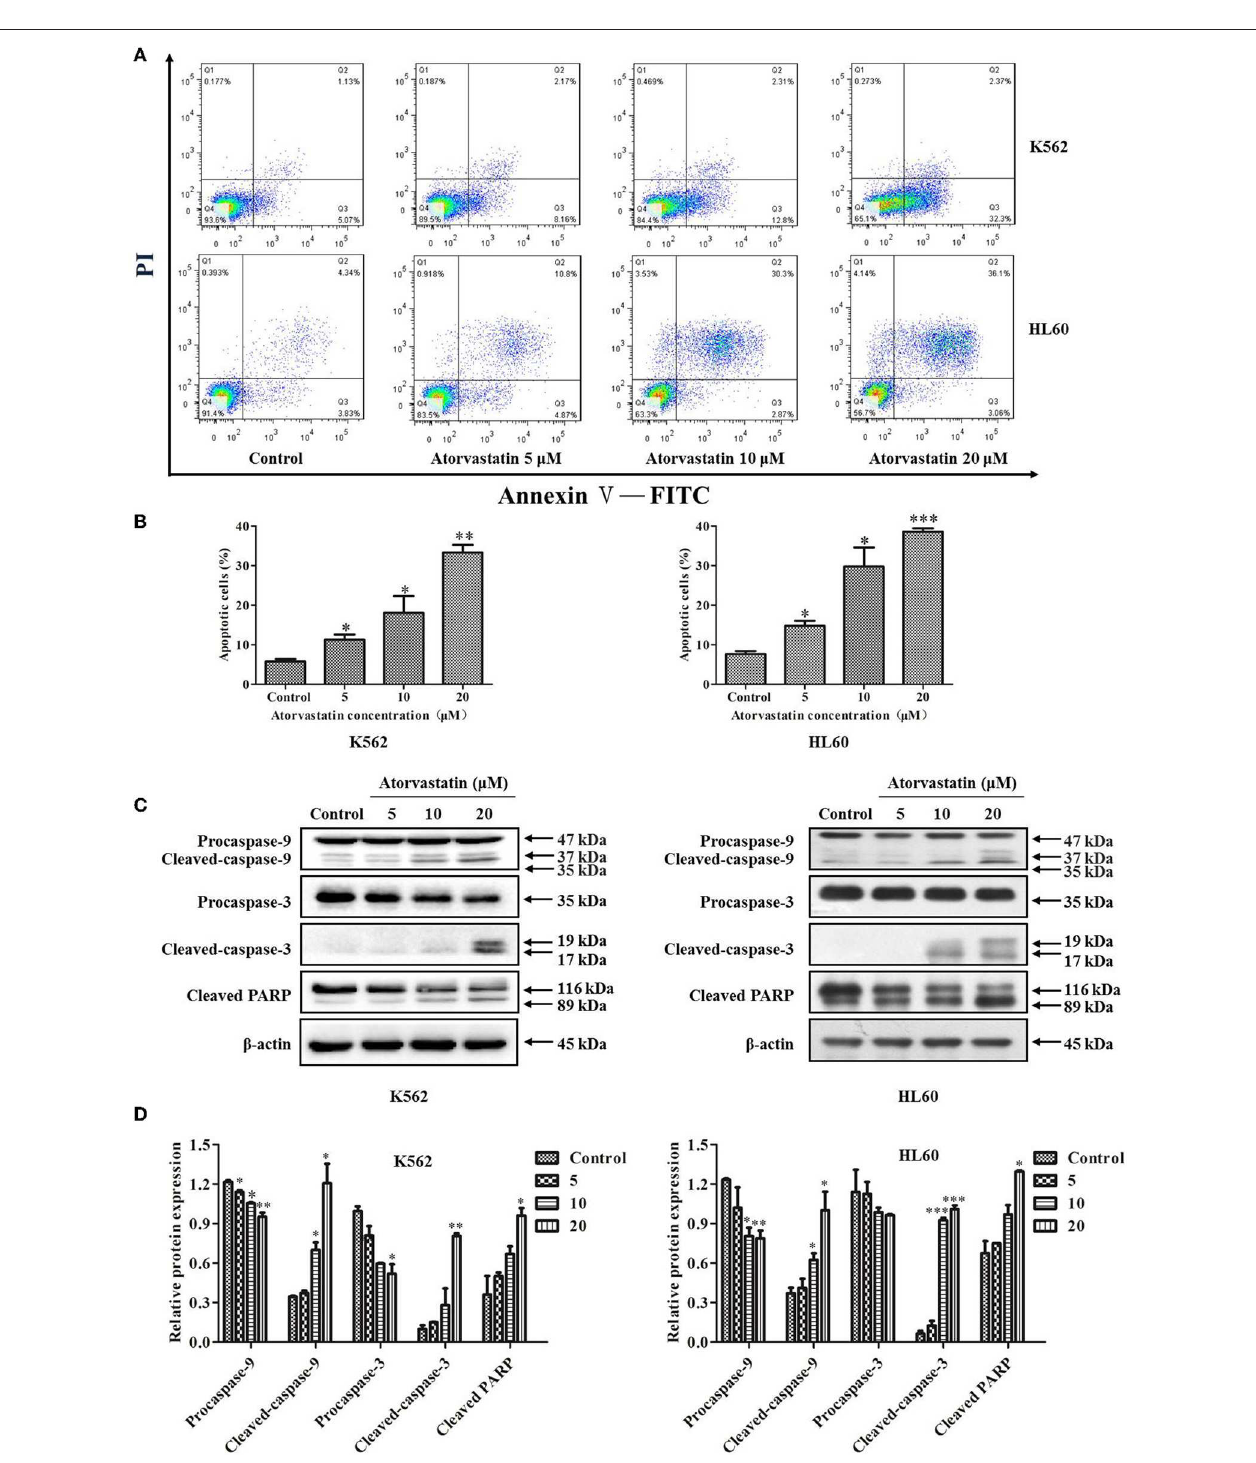
FIGURE 3 | Atorvastatin induces apoptosis in K562 and HL60 cells. K562 and HL60 cells were incubated with Atorvastatin (0, 5, 10, and 20 µ M) for 48h. (A) The apoptosis was examined by flow cytometer, and the representative images were shown. (B) The percentages of apoptotic cells were shown and statistically analyzed. (C) The levels of caspase-9, caspase-3, and PARP were determined by western blot. (D) Bar graphs show the relative levels of caspase-9, caspase-3, and PARP. Data are presented as mean ± SD of three independent experiments. * p < 0.05, ** p < 0.01, *** p < 0.001 vs. control.